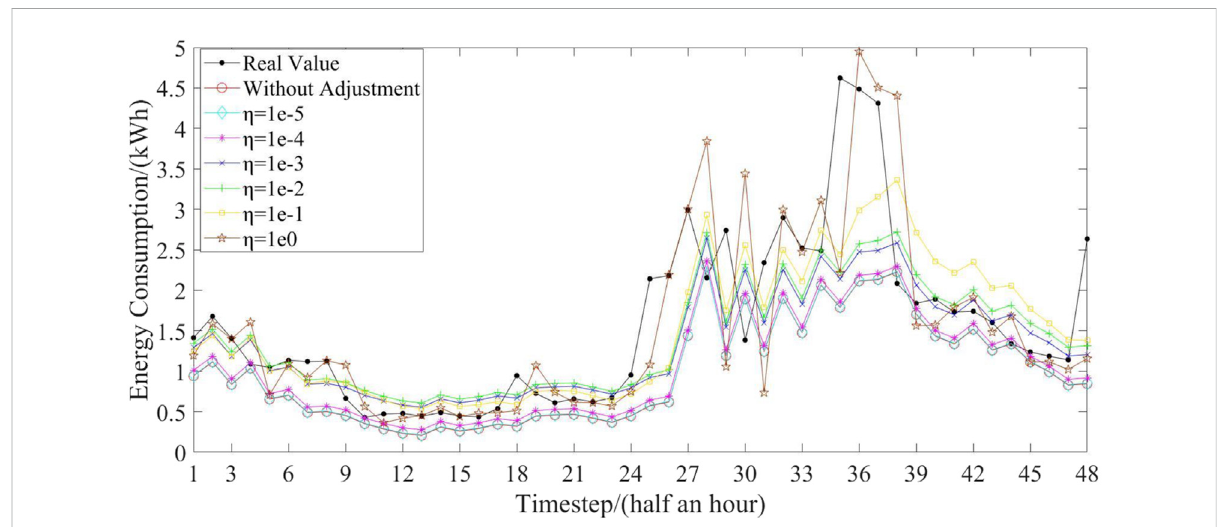
FIGURE 7 Load pro fi les of the proposed method for different values of parameter η (Resident 1425).